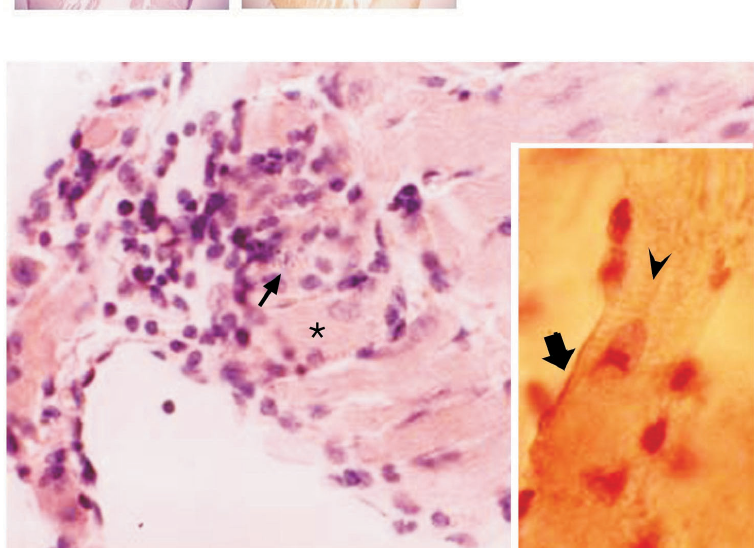
Figure 3. Immunohistochemical staining for protein nitrotyrosine residues in heart of BALB/c mice. The immunostaining was carried out as described in Ma- terial and Methods. A , Non-in- fected animal; B , C and D , in- fected animals. B , Control with pre-immune serum; C , the anti- nitrotyrosine Ab binding was blocked with 5 mM nitrotyrosine; D , slide incubated with anti-ni- trotyrosine Ab. A diffuse immu- nostaining (brown color) is ob- served in infected mice (D), but not in non-infected mice (A), nei- ther in control (B, C). Magnifica- tion 2X.